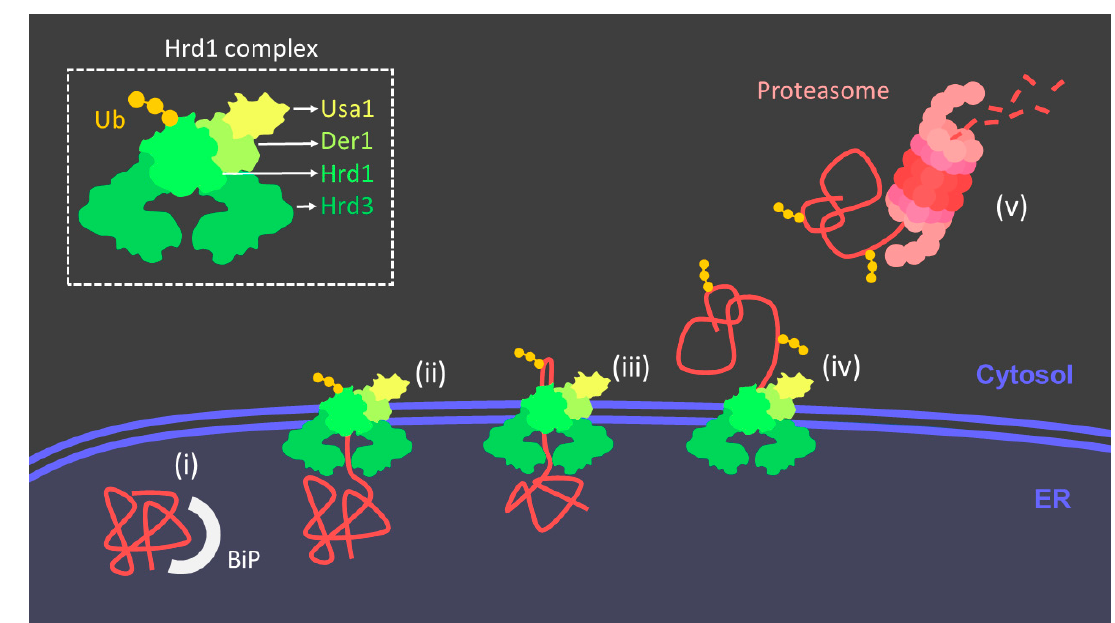
Figure 3. Recognition, retro-translocation, polyubiquitination, and proteasomal degradation of soluble ERAD Substrates. ( i ) Recognition of misfolded proteins by the ER-resident chaperones like BiP targeting them for retro-translocation. ( ii ) Initiation of retro-translocation crossing the Hrd1 complex, constituted by several subunits such as Hrd1, Hrd3, Der1, and Usa1; other subunits are not represented. ( iii ) The catalytic domain of Hrd1 polyubiquitinates the emerging protein in the cytosol. ( iv ) Further retro-translocation and polyubiquitination aided by cytoplasmic ubiquitin-binding protein complexes (not shown). ( v ) Proteasome degradation where the protein is broken down into peptide fragments.